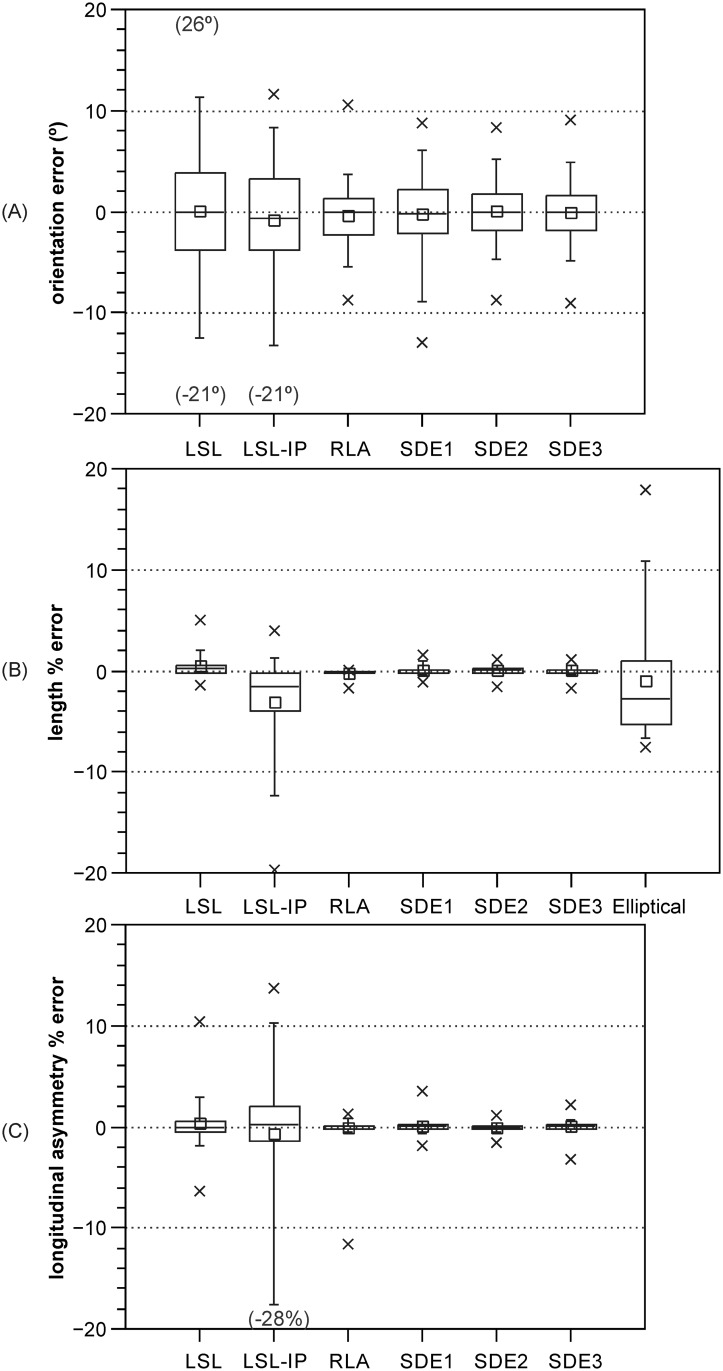
Error distributions for LSBs with elongation < 5.The box corresponds to the interquartile range; the horizontal line and the small square within the box plot the median and the mean, respectively; the whiskers represent the 5th and 95th percentiles; the crosses plot the minimum and maximum errors. Where maximum or minimum error exceeds chosen vertical scale (same across graphs for comparability), its value is provided within brackets. Errors correspond to the difference between the values from the automated method and from the reference LA. For length and longitudinal asymmetry (ASpl_A [11]), errors correspond to the % difference relative to value derived from the reference LA.